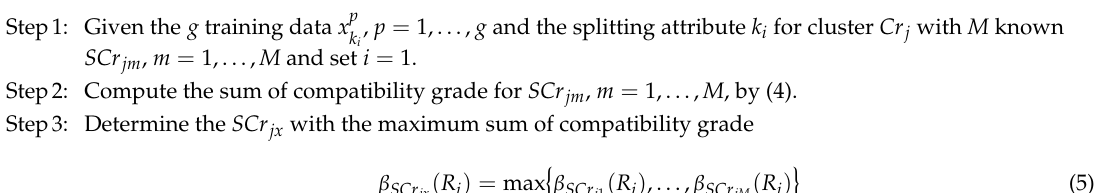
Algorithm 2 : Generate the fuzzy rules